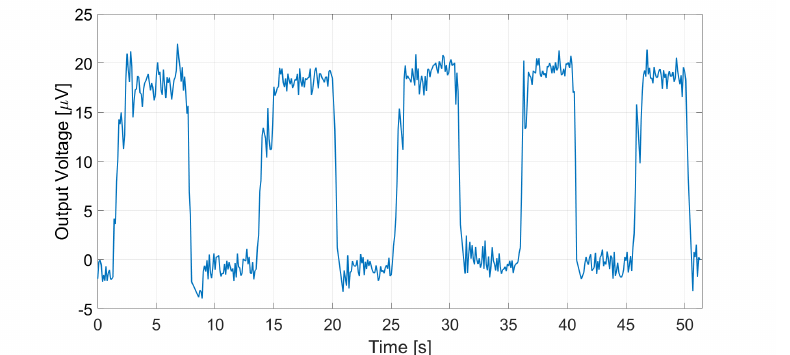
Figure 17. Measured E1 thermopile output in the case of a hand moved in front of the sensor at 5 cm